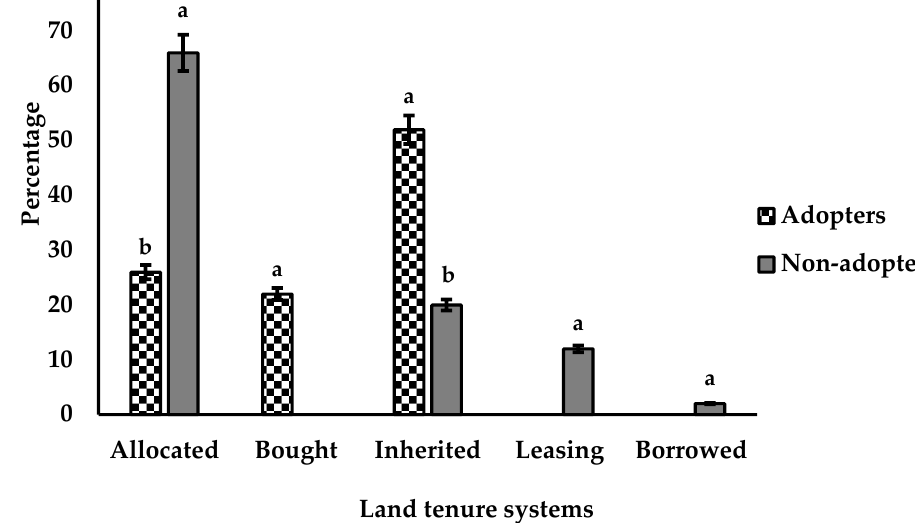
Figure 3. Land tenure systems of SHF.